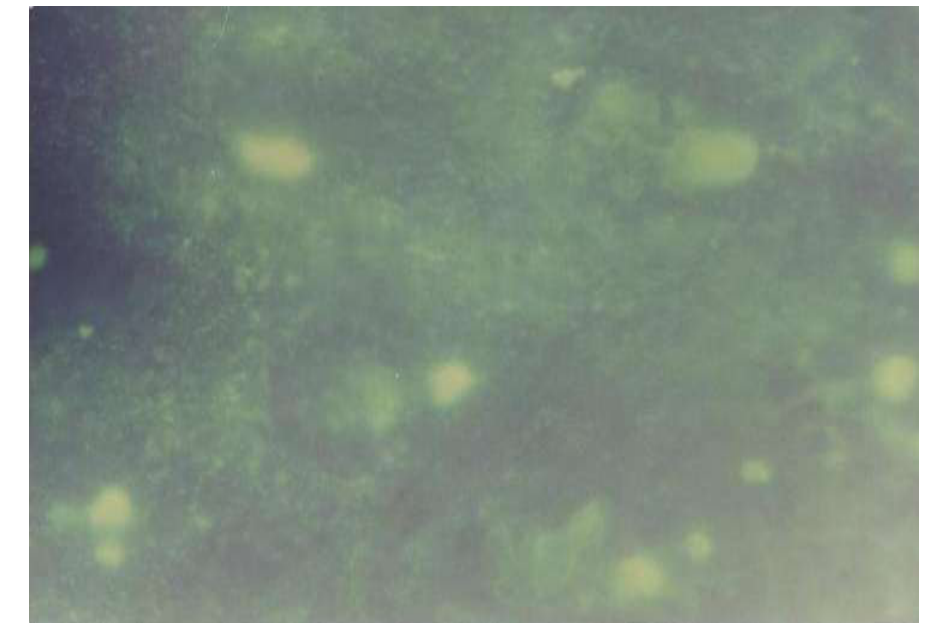
Fig. (2): The mesenteric lymph node of the calve sacrificed 36 hours (PI), showing salmonella in the